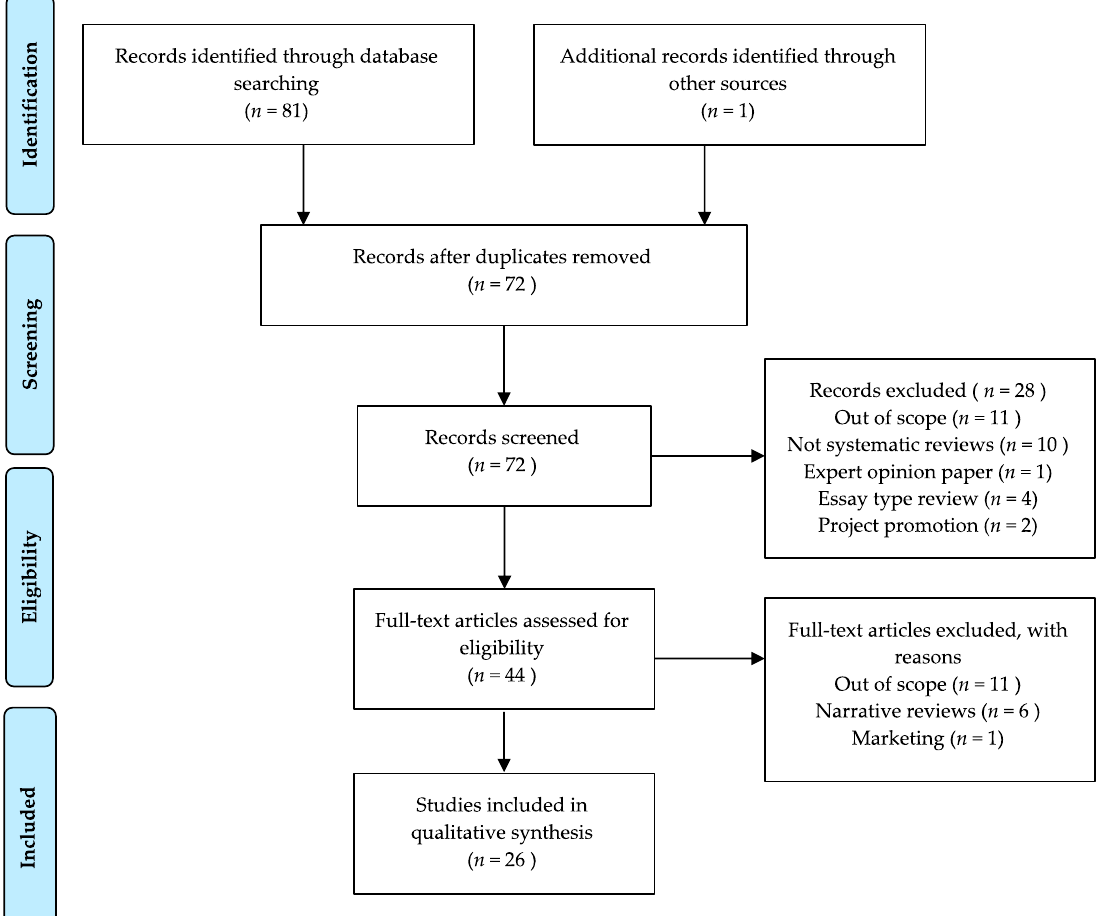
Figure 1. PRISMA flow-diagram for the selection of studies.